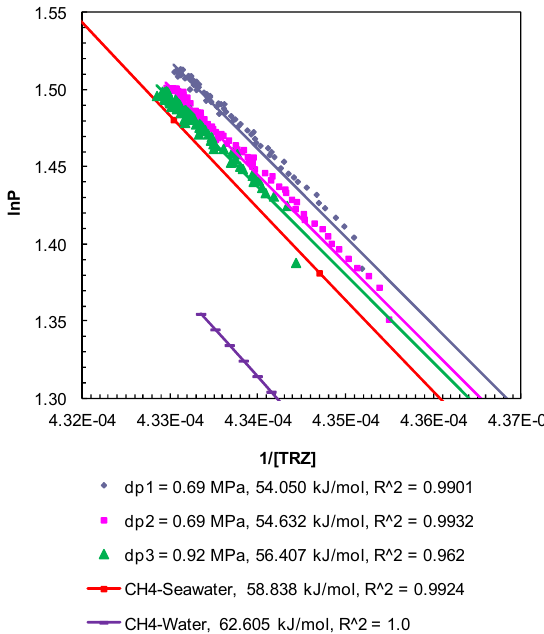
Figure 6. Post-depressurization (dps1–3) P - T conditions from Experiment 2 plotted as ln P against 1/[ T R Z ]. The Clausius-Clapeyron equation was used to calculate enthalpy of dissociation ( ∆ H in kJ/mol) of methane hydrates from seawater in porous media at a hyd confining pressure of 10.44 MPa. The R 2 values indicate the correlation coefficient for . linear regression performed to compute the slope as ∆ H hyd